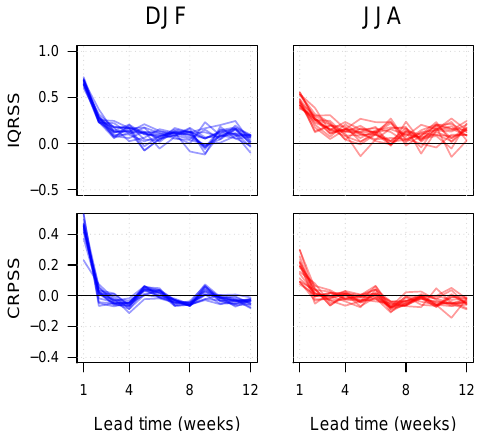
Figure 9. Skill of weekly precipitation forecasts corrected with EDMD-m as a function of the lead time for all catchments and for the winter (DJF) and summer (JJA) seasons. The skill is computed based on the IQR (top) and the CRPS (bottom) and the reference is historical precipitation. Each column corresponds to a target sea- son. Each line represents the skill score in a catchment for forecast horizons within the target season.